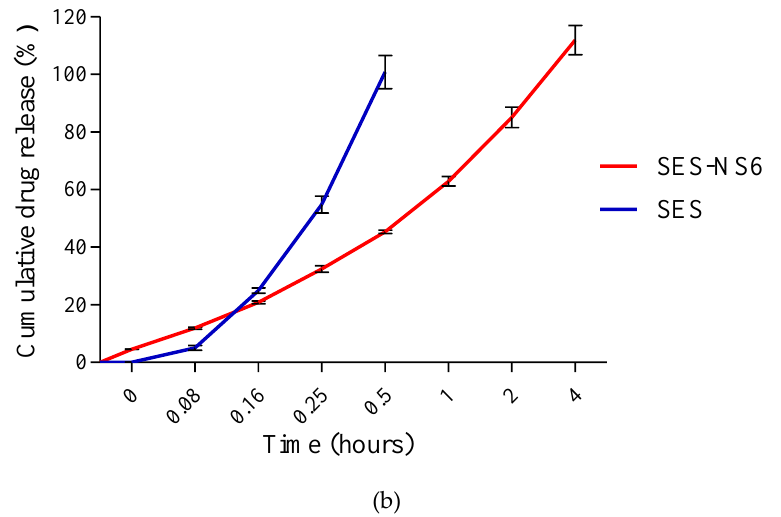
Figure 7. In vitro drug release profile of bare sesamol (SES) and sesamol-laden nanosponges (SES- NS6) in buffer solution at ( a ) pH 7.4 and ( b ) pH 4.5.